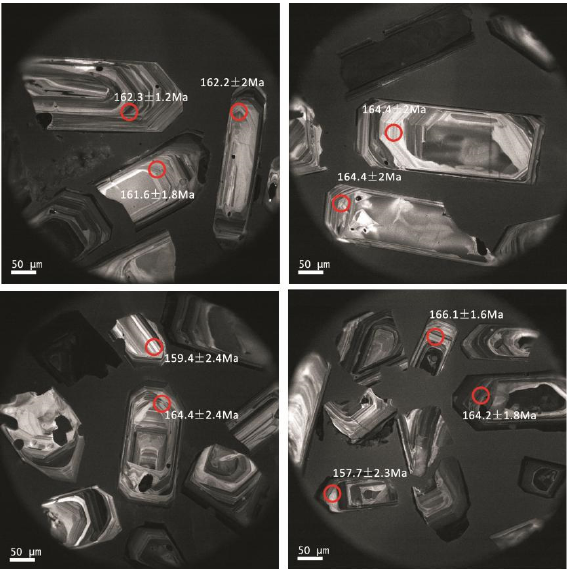
Figure 5. CL images of selected dated zircons from medium- and coarse-grained biotite granite. The red circles and nearby numbers indicate the spot locations and concordant ages.